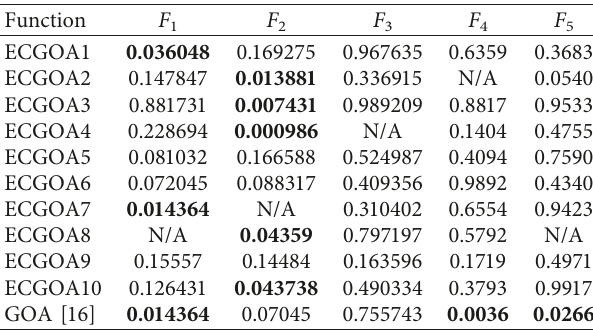
Table 7: Results of the Wilcoxon rank sum test on unimodal benchmark functions.